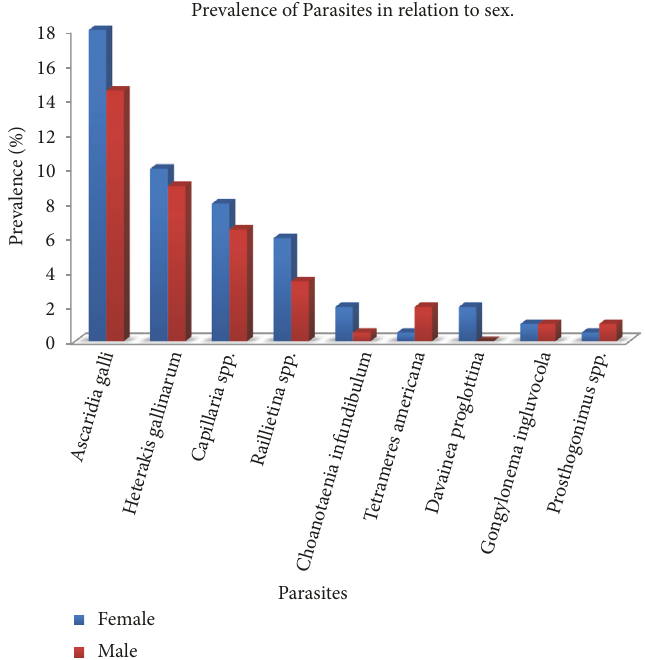
Figure 2: A chat showing the prevalence of gastrointestinal helminth in relation to